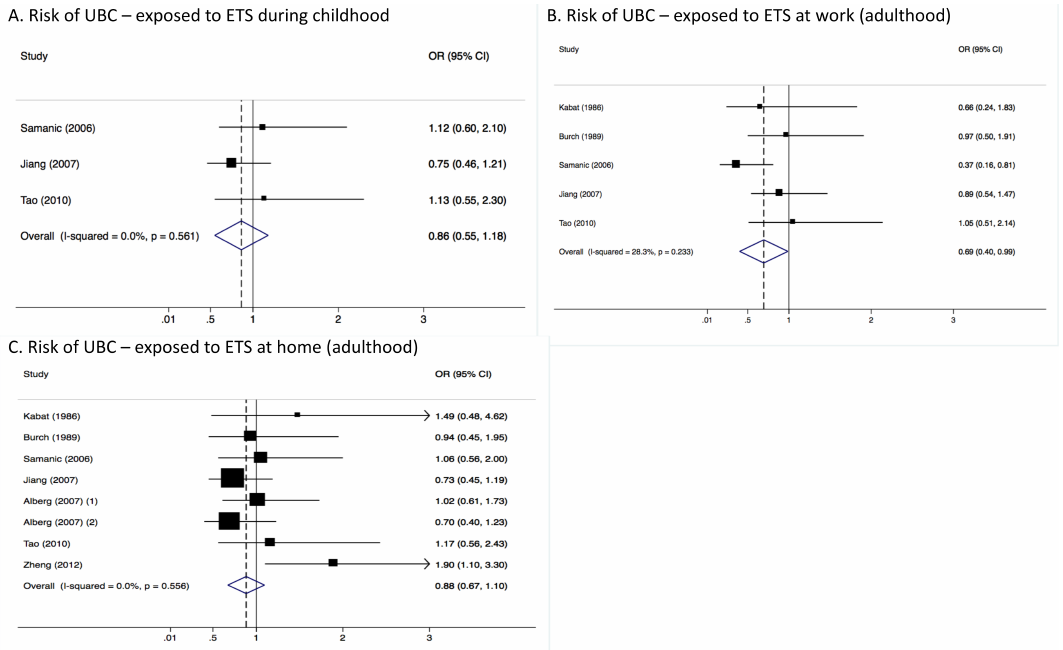
Figure 2. Meta-analysis results showing pooled risk estimates for urothelial bladder cancer (UBC) stratified by timing (childhood or adulthood) and location (work-related or domestic) of exposure to ETS for males only.